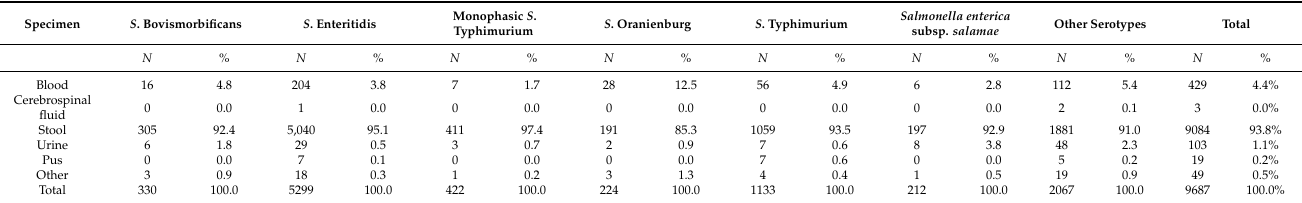
Figure 2. The distribution of Salmonella spp. per serotype by age group, Greece, 2003–2020. Data on the sex of the patients (9491 isolates) revealed an equal distribution in males and females (51.5% and 48.5%, respectively). Information on the type of specimen where Salmonella spp. were isolated was available for 9687 isolates (Table 3). The majority was isolated from stool samples (almost 94%) and 4.4% ( n = 429) from blood. Of the 429 isolates from blood, 204 (47.5%) were S . Enteritidis, 56 (13%) S . Typhimurium and 28 (6.5%) S . Oranienburg. S . Oranienburg presented the highest isolation rate from the blood samples (12.5%, 28/224). Table 3. The type of specimen where Salmonella spp. was isolated for S. Enteritidis, S Typhimurium, Monophasic S. Typhi- murium, S. Bovismorbificans, S. Oranienburg, S. enterica subsp. salamae and all other serotypes, Greece, 2003–2020 ( N = number, % = percentage).